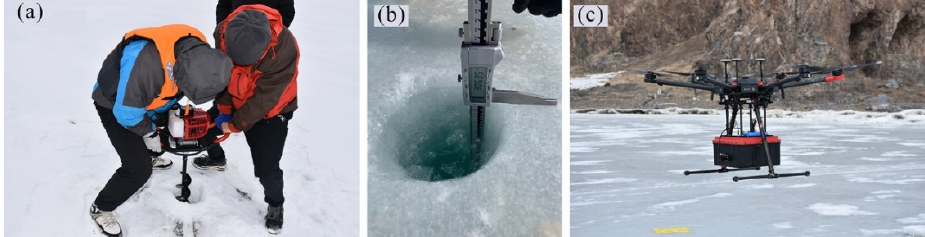
Figure 3. Lake ice thickness measurements via drilling ( a , b ) and airborne ice measuring radar ( c ) in Qinghai Lake during January–March 2019. Table 2. In–situ ice thickness data of Qinghai Lake from January 2019 to March 2019.